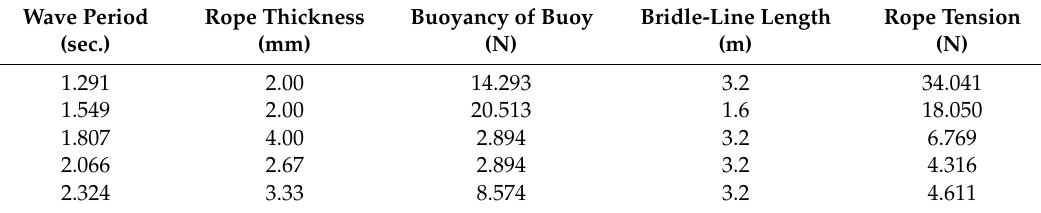
Table 3. Conditions with minimum mooring tension according to the wave